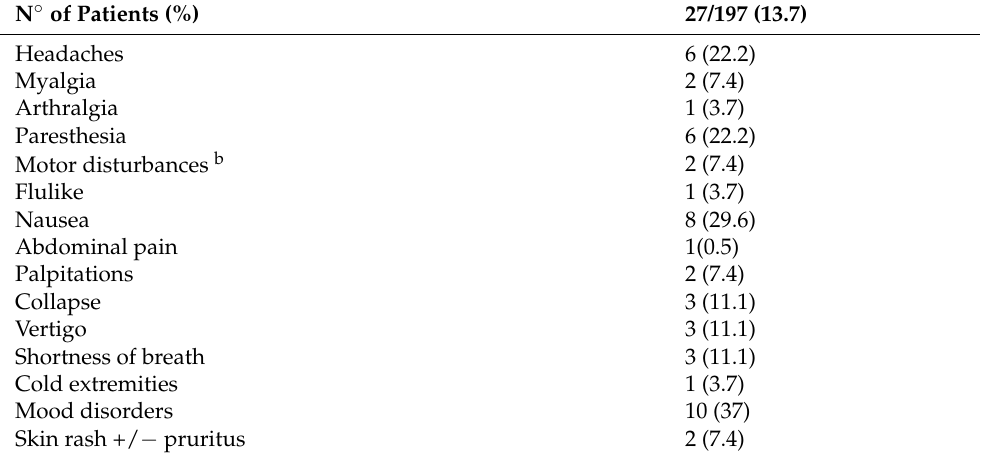
Table 2. Prodromal new or non-typical symptoms a